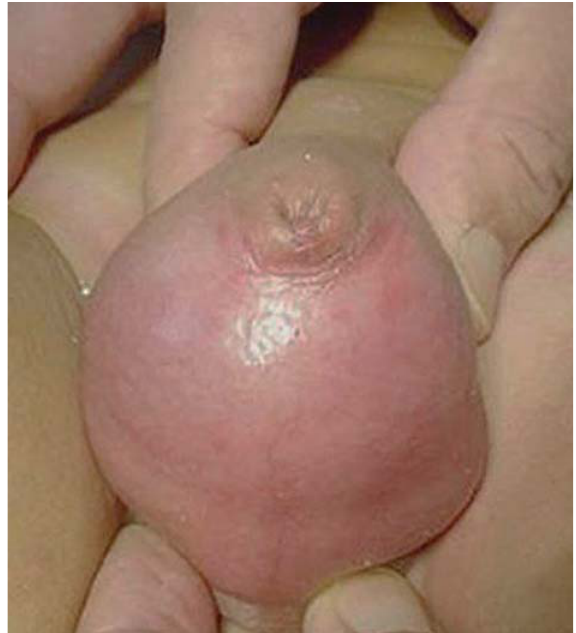
Figure 3 – (cid:3)(cid:55)(cid:75)(cid:72)(cid:3)(cid:68)(cid:85)(cid:85)(cid:82)(cid:90)(cid:3)(cid:86)(cid:75)(cid:82)(cid:90)(cid:86)(cid:3)(cid:87)(cid:75)(cid:72)(cid:3)(cid:88)(cid:85)(cid:76)(cid:81)(cid:68)(cid:85)(cid:92)(cid:3)(cid:77)(cid:72)(cid:87)(cid:3)(cid:192)(cid:82)(cid:90)(cid:3)(cid:90)(cid:75)(cid:72)(cid:81)(cid:3)(cid:87)(cid:75)(cid:72)(cid:3) foreskin is